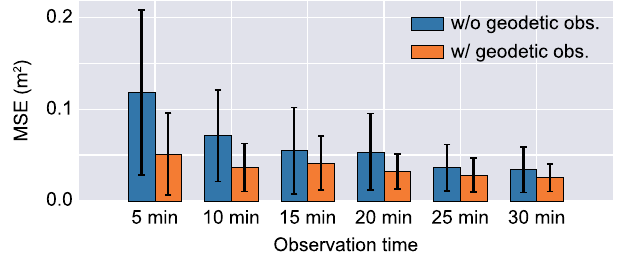
Fig. 4 Mean squared error (MSE) in the convolutional neural network (CNN) tsunami forecasts for 1000 test scenarios with different observation lengths with or without geodetic data. The height of the bar represents the mean value for 1000 test scenarios, and the error bar in the fi gure represents the standard